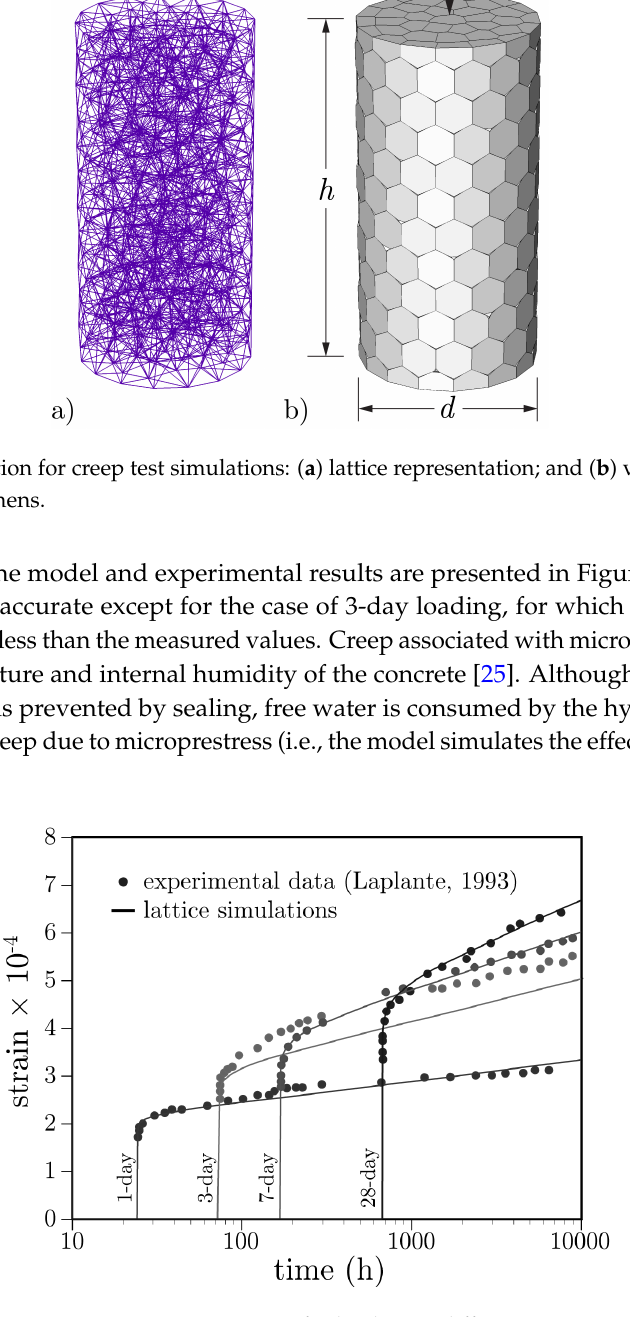
Figure 7. Basic creep curves for loading at different